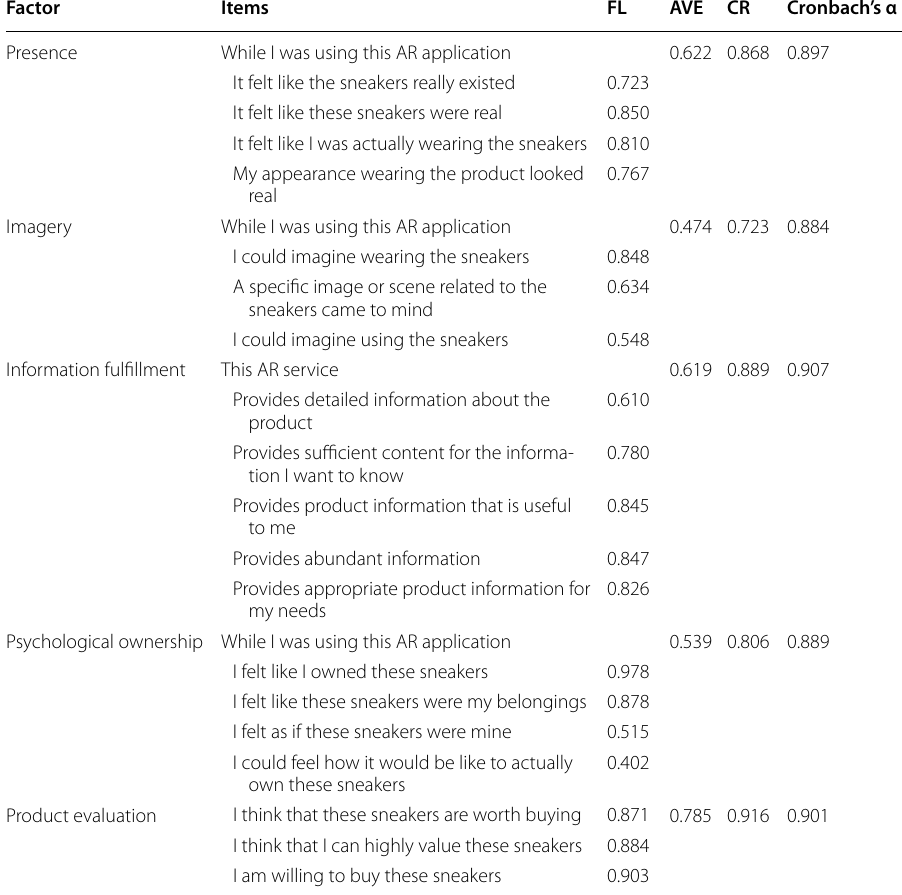
Table 1 Measurement assessment